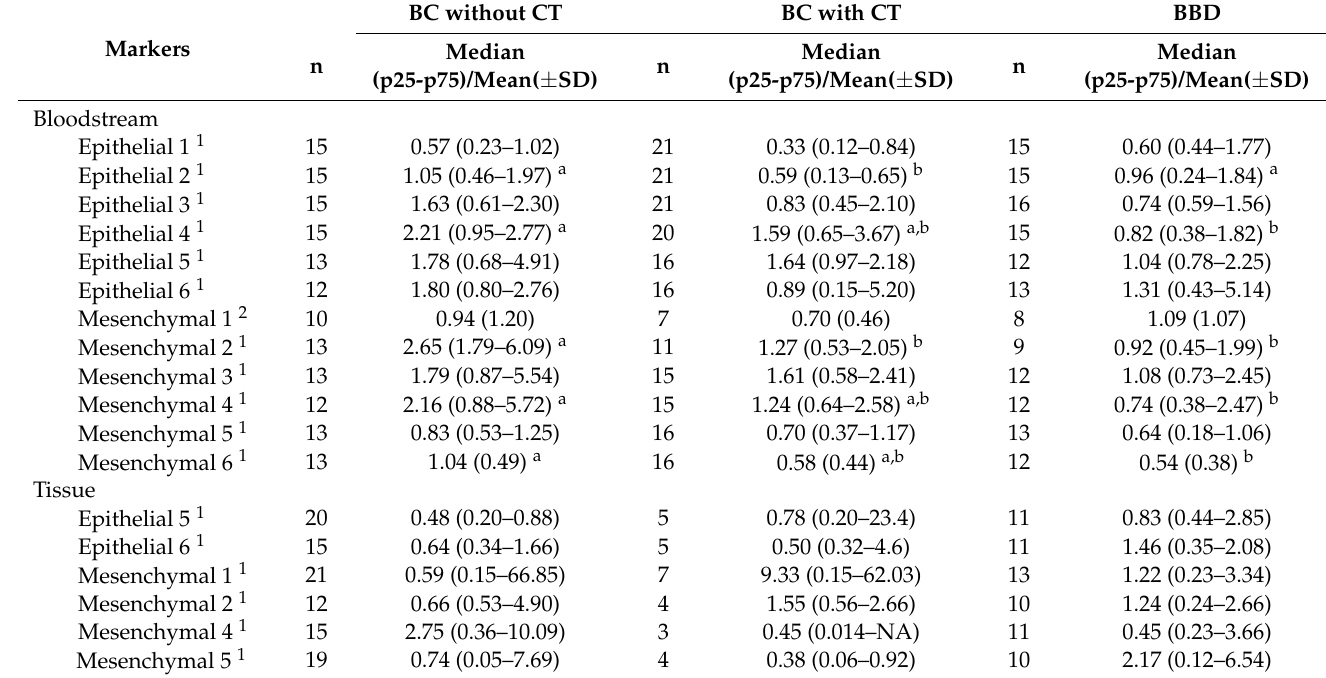
Table 3. Influence of chemotherapy on transcriptional levels of target genes.